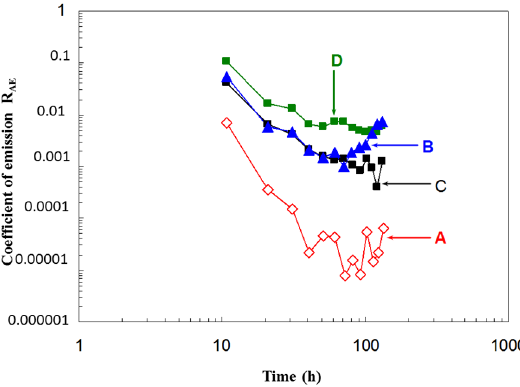
Figure 12. Evolution of the coefficient of emission for several clusters at 500 °C and σ / σ R = 0.79.